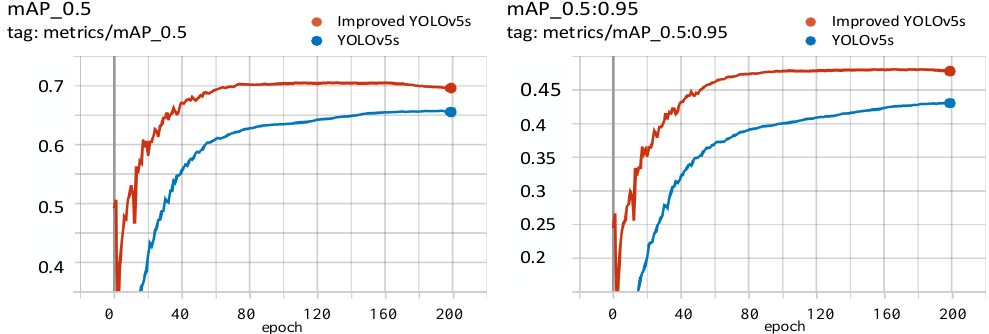
Figure 14. Pascal voc 2012 dataset validation comparison.